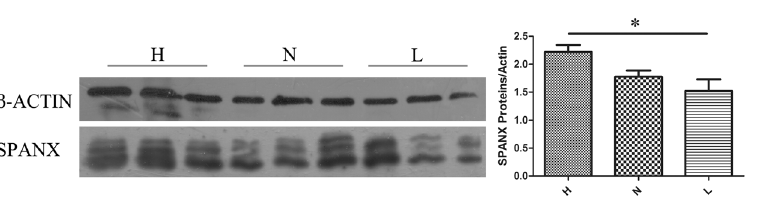
Figure 4. The western blotting detected SPANX proteins expression in high fecundity group (H, pregnant rate > 50%), normal group (N, pregnant rate = 25%), low fecundity group (L, pregnant rate = 0), Figure B revealed the expression levels between the three group (gray value ratio of target protein and β -actin, paired t test, * p < 0.05.